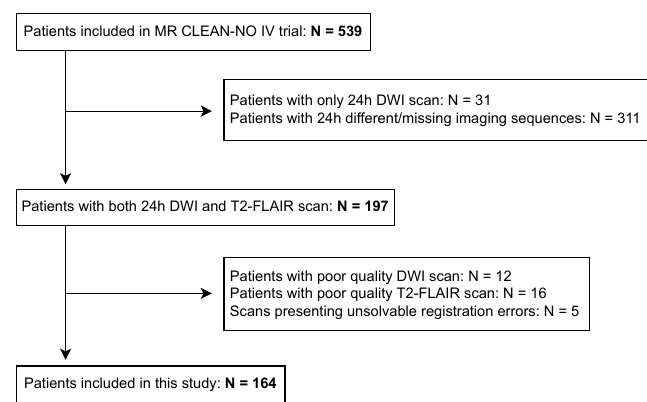
Figure 2. Flow chart of the patient inclusion process.